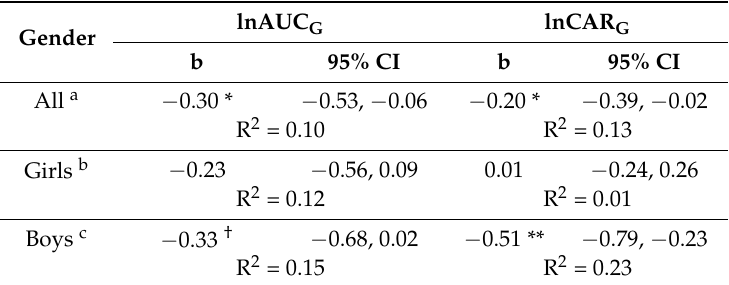
Table 3. Results from linear (OLS) regressions of cortisol output by exposure to bullying. Estimates are presented for bullied students (omitted reference category = not bullied).